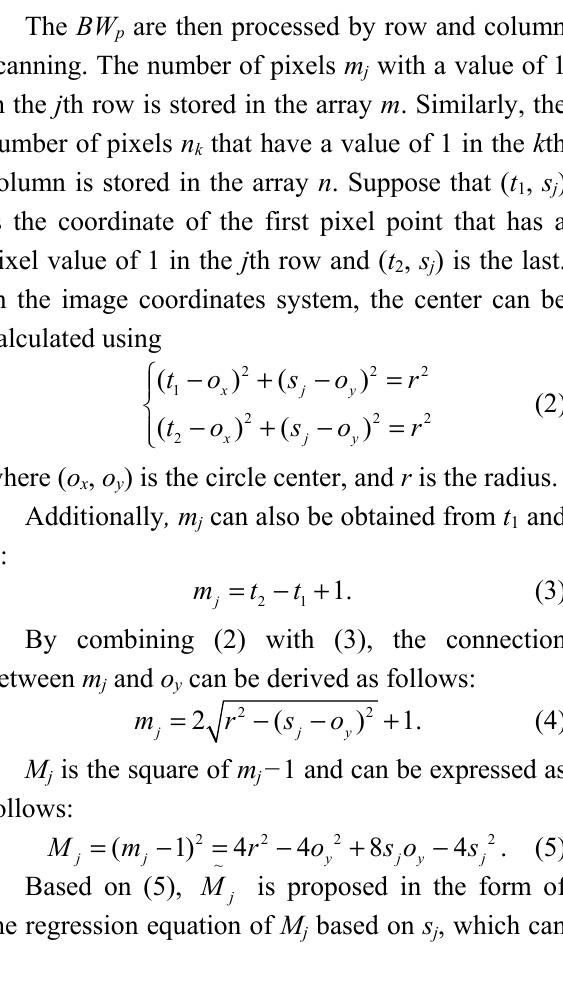
Fig. 6 Principle of pixel statistical